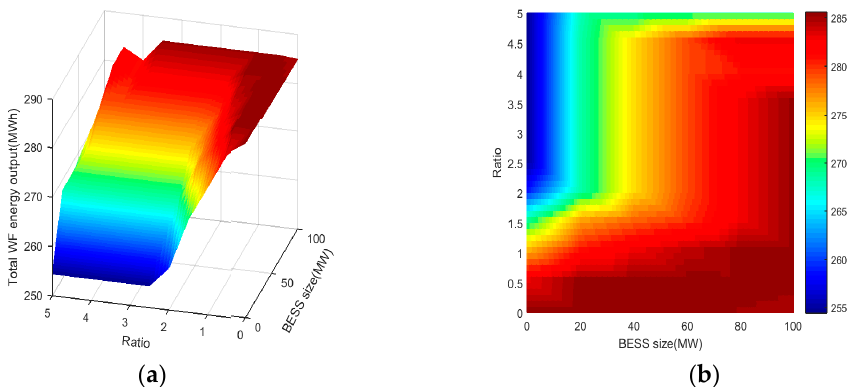
Figure 10. Effects of ratio ( β / α ) and BESS size on total WF energy output during scheduling horizon: ( a ) Front view; ( b ) Top view.